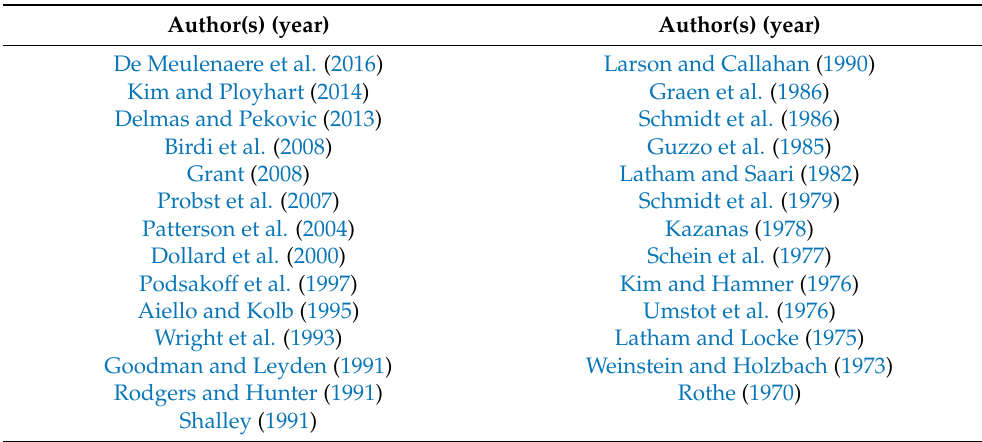
Table A1. The 27 articles used in the